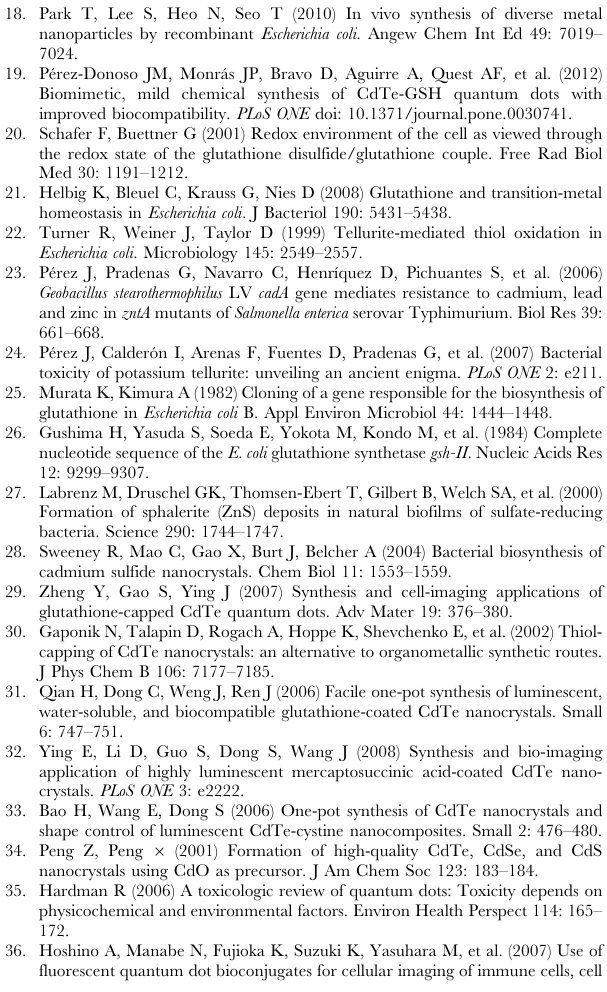
Figure S2 AFM of biosynthesized CdTe QDs. Biologically synthesized CdTe nanoparticles were purified as described in Methods and the nanometric size was evaluated by AFM. (TIF) Figure S3 Effect of pH on nanoparticle biosynthesis. E. coli gshA were grown to stationary phase and suspended in water or phosphate buffer adjusted to different pH values. Cells were exposed to both CdCl 2 and K 2 TeO 3 in (left to rigth): water or (TIF) Figure S4 Synthesis of CdTe QDs in bacterial growth media. Fluorescence spectra of CdTe QDs synthesized in LB media, pH 7.0, amended with 4 mM CdCl 2 , 1 mM K 2 TeO 3 , 15 mM MSA and 10 mM NaBH 4 at the indicated time intervals. (TIF) Table S1 Bacterial strains used in this